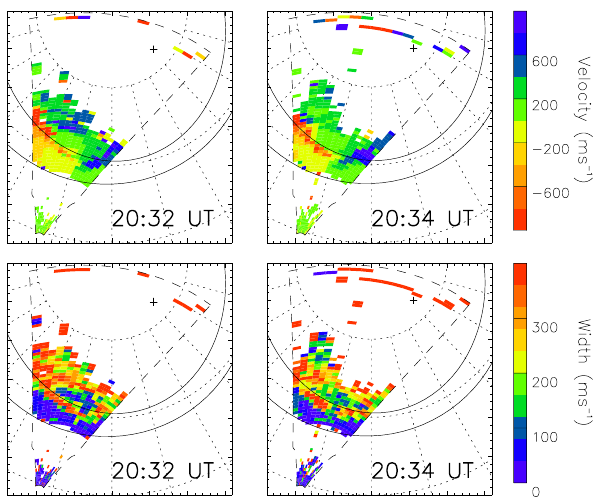
Fig. 8. Full radar scans of line of sight velocity (top panels) and spectral width (bottom two panels) for scans starting at 2032 UT and 2034 UT. The coordinate system is magnetic local time/magnetic latitude based upon the AAGCM coordinates of Baker and Wing